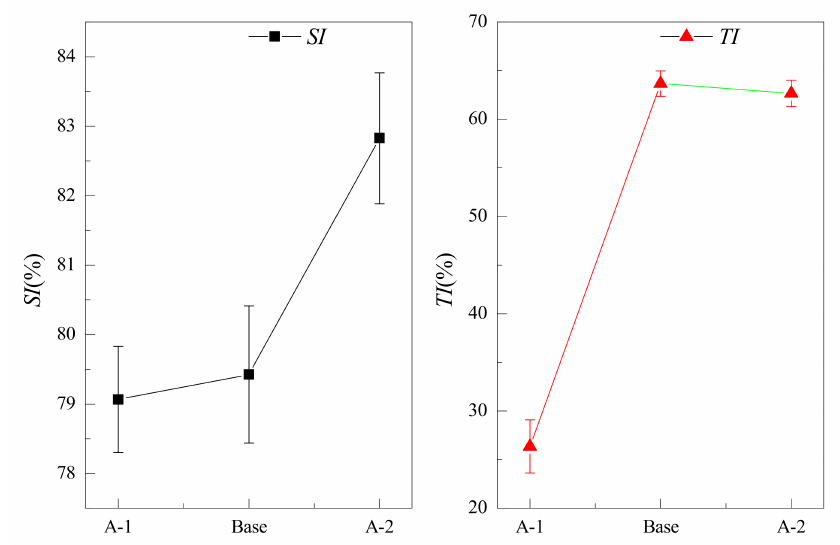
Figure 4. Influences of carbon addition in the sintering mixture on sinter quality. (The carbon amount: A-1 = 2.6%; Base = 2.8%; A-2 =